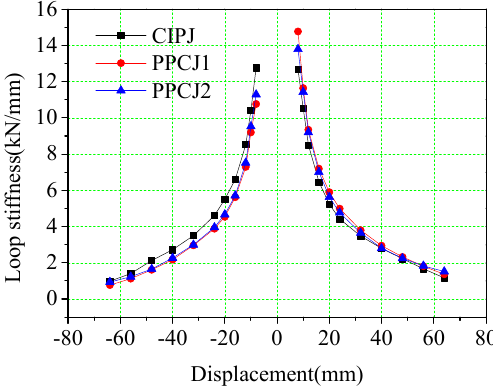
Figure 18. Relationship between loop stiffness and displacement of the joint left beam.